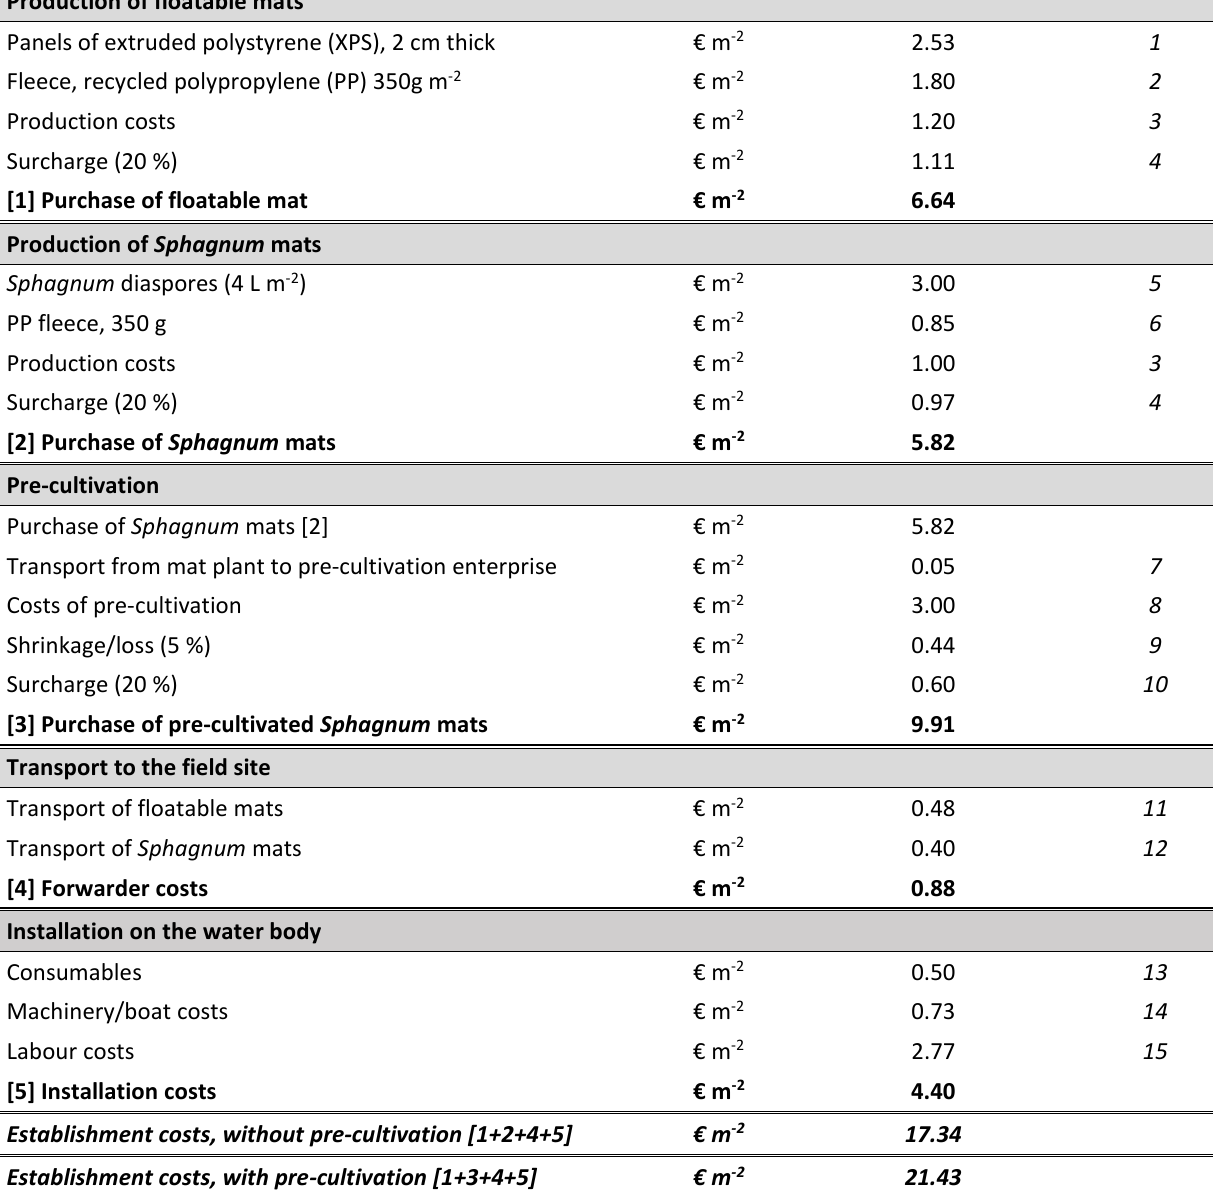
Table 5. Material, production and installation costs per square metre of water-based Sphagnum farming site. Production of floatable mats Panels of extruded polystyrene (XPS), 2 cm thick € m -2 Fleece, recycled polypropylene (PP) 350g m